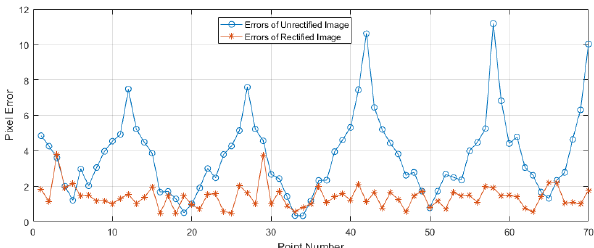
Figure 10. Comparison of the errors of rectified and unrectified X-ray image, at the vertical dimension between test plate and receiving end of C-arm of 45 mm.